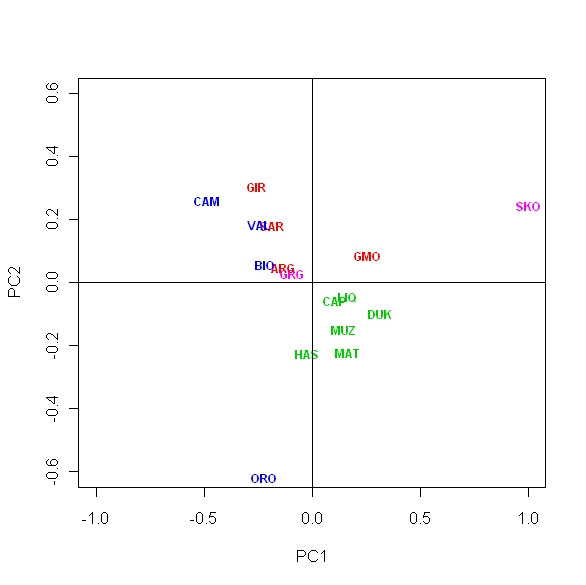
Principal component analysis (PCA) of allele frequencies from twenty three SNP loci genotyped in the sixteen goat breeds. Projection on axis 1 and axis 2, which cumulatively explained 52% of the total inertia contained in the data set. Breeds acronyms as in Table 1. Albanian breeds, green; North Italian breeds, blue; South Italian breeds, red; Greek breeds, pink.